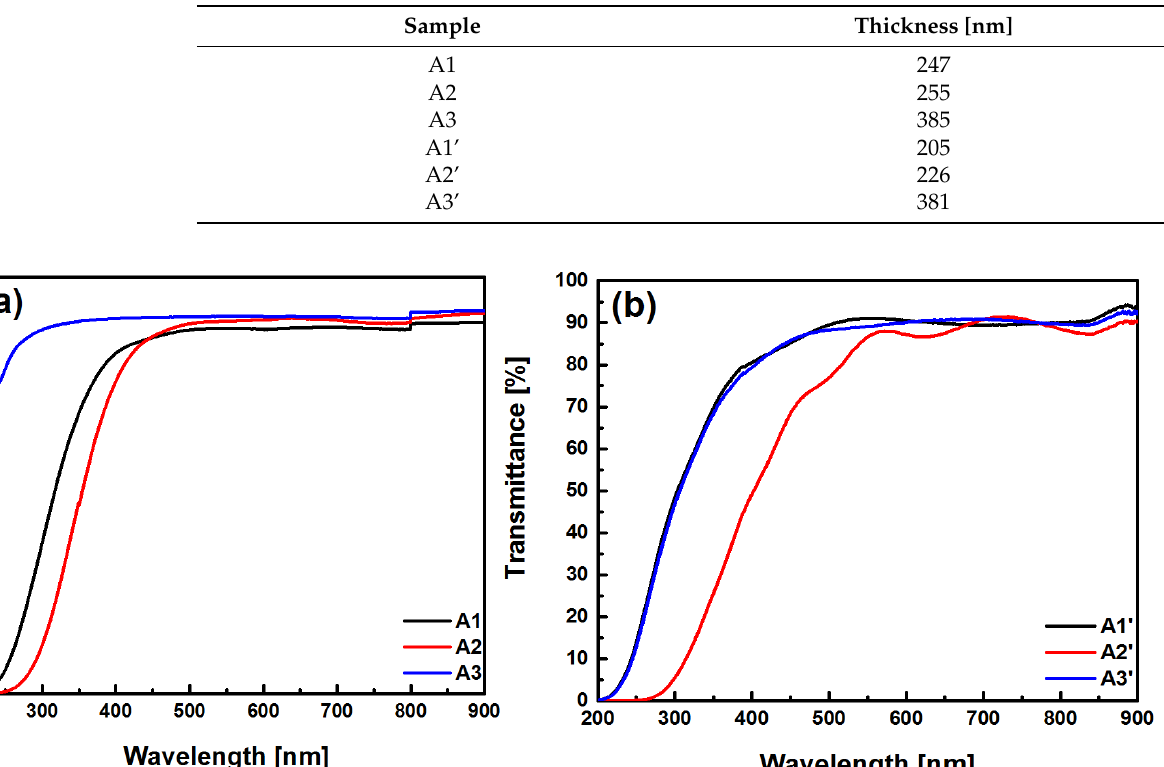
(cid:2869) (cid:2870)(cid:3415) =